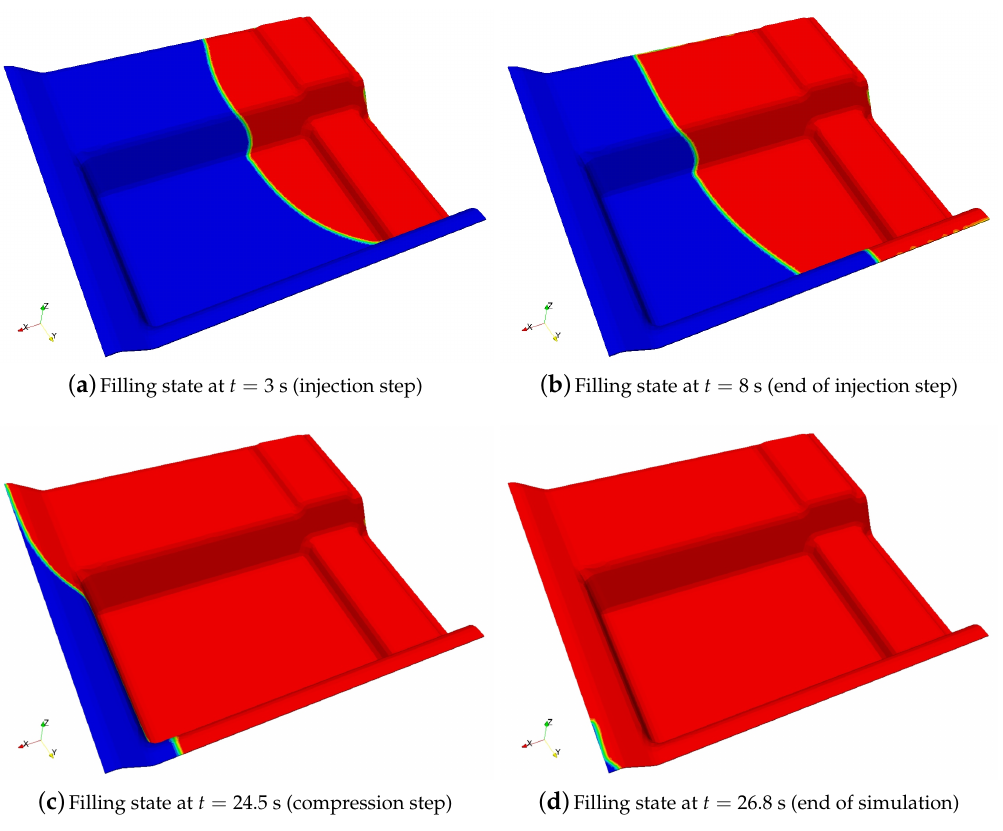
Figure 11. Filling state of four time steps of the simulation of the complex